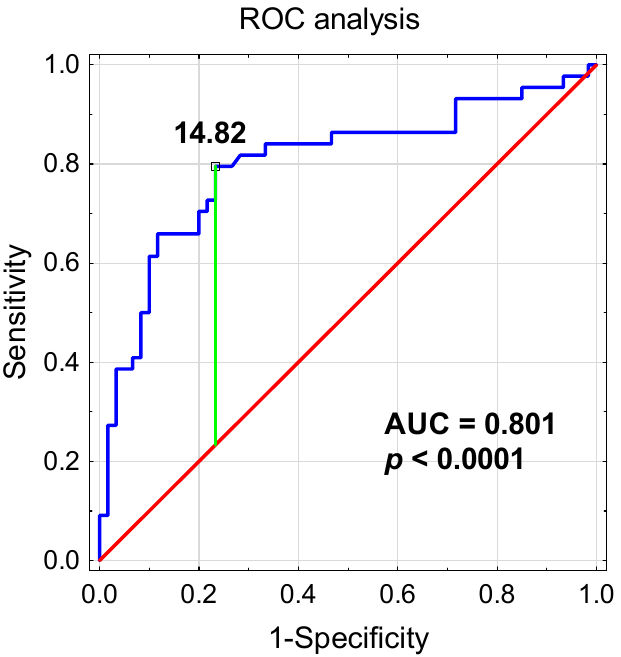
Figure 5. ROC and AUC were used to evaluate the sensitivity and specificity and to calculate the most significant cut-off value of TEM percentage that best distinguished ZAP-70-positive and ZAP-70-negative cases. ROC, receiver operating characteristic; AUC, area under the curve; TEM, Tie-2 expressing monocytes.